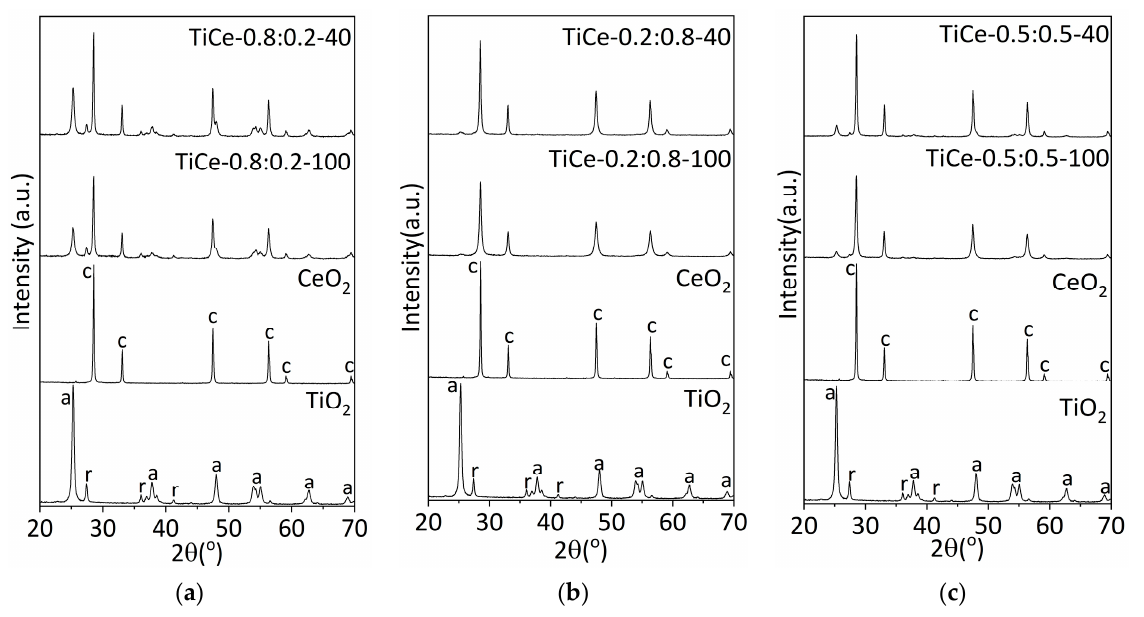
Figure 3. XRD patterns of starting oxides and mixtures of the following composition: ( a ) TiO 2 :CeO 2 = 0.8:0.2; ( b ) TiO 2 :CeO 2 = 0.2:0.8; ( c ) TiO 2 :CeO 2 = 0.5:0.5; a—anatase, r—rutile, c—ceria fluorite structure.